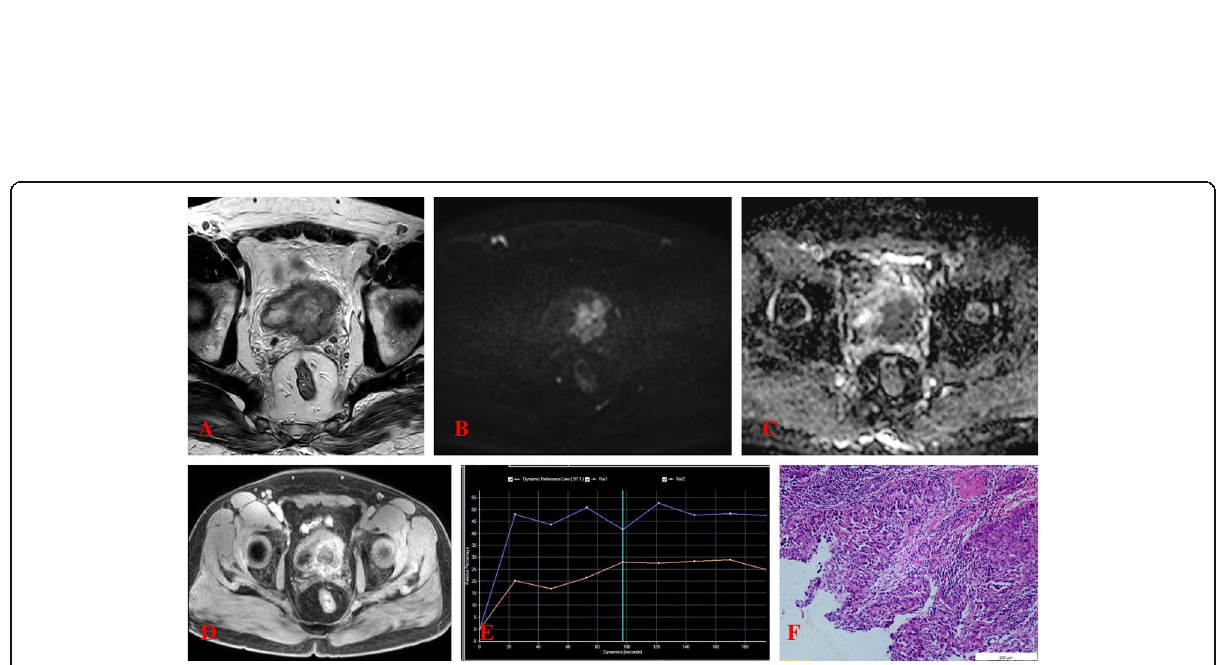
Fig 6 A 58-year-old male patient presented with history of recurrent hematuria and pelvic pain. Axial T2 WI ( a ) showed intra-vesical soft tissue mass arising from dome and high left posterolateral bladder wall expressing intermediate signal intensity with infiltration of the muscle layer and perivesical fat. Axial DW-MRI (b1000) ( b ) showed restricted diffusion of the mass with infiltration of the perivesical fat. Axial ADC map ( c ) showed low SI of the lesion with ADC value = 0.85 × 10 – 3 mm 2 /s, consistent with high-grade tumor. Axial post contrast T1WI FAT-SAT ( d ) showed early heterogeneous enhancement of the mass with cystic degeneration and infiltration of the perivesical fat. Time-intensity curve ( e ) showed grade 3 curve with early enhancement and rapid washout. Multiparametric MRI features of low-grade stage T3 muscle-invasive urinary bladder carcinoma. Microscopic image of histopathology ( f ) demonstrated high-grade urothelial carcinoma which confirms the multiparametric MRI